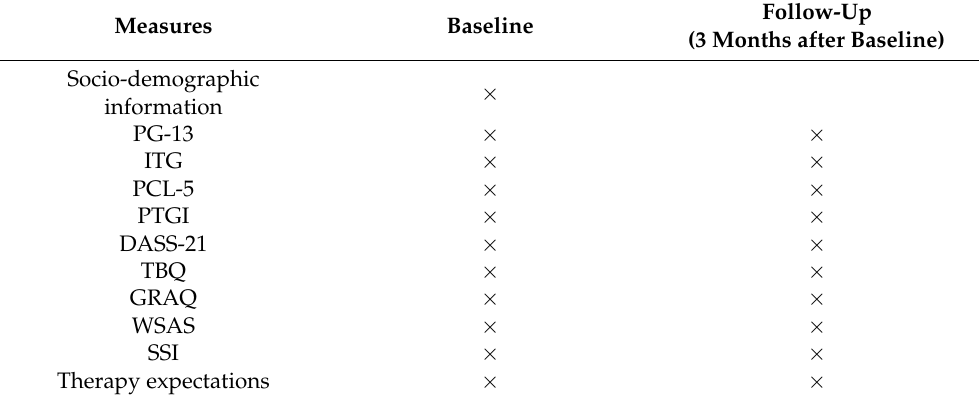
Table 1. Schedule of